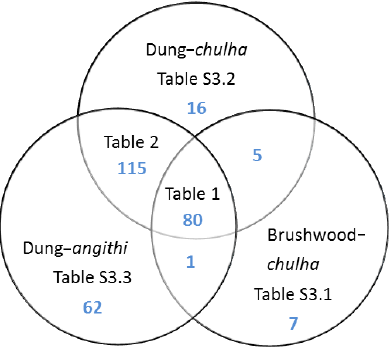
Figure 3. An overview of the particle-phase compounds inventory based on the results of molecular characterization using nano-DESI- HRMS. Each area of the Venn diagram contains the bolded number of reproducibly detected formulas in blue, as well as the Table that lists peaks for each category. Merging all of the tables listed here provides a complete inventory of compounds detected in this